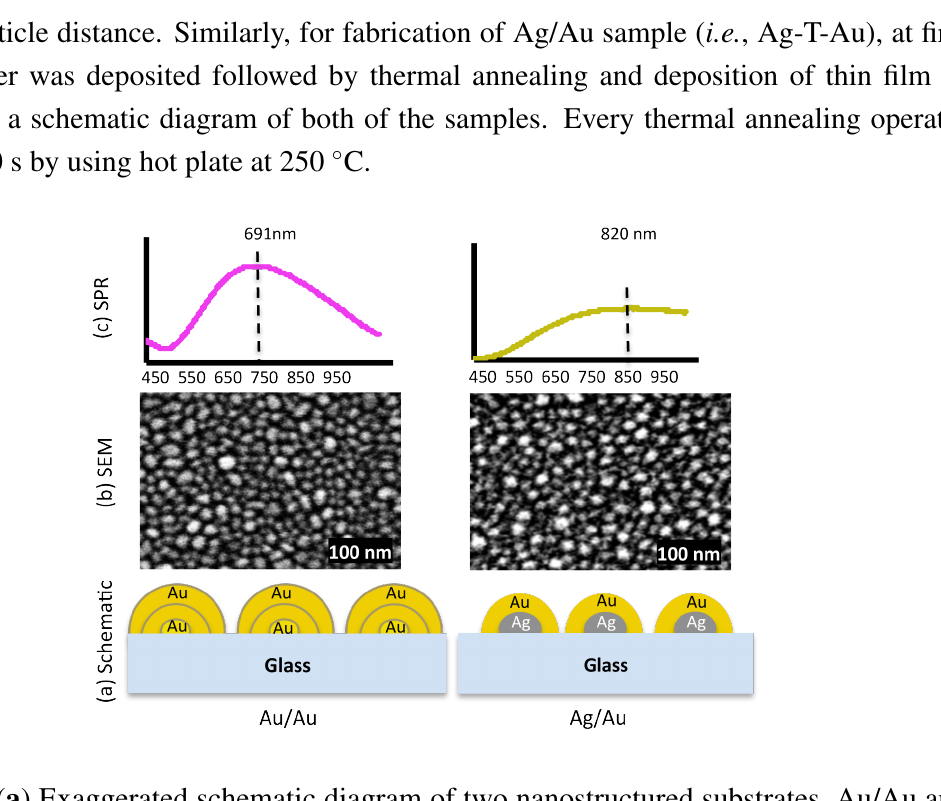
Figure 1. ( a ) Exaggerated schematic diagram of two nanostructured substrates, Au/Au and Ag/Au. ( b ) The SEM images show that the nanostructures are different in shape, size and inter-structure spacing. In the Au/Au sample, the smallest size is ≈ 6 nm and the largest ≈ 47 nm, and for Ag/Au sample, the smallest size is ≈ 6 nm and the largest ≈ 36 nm. ( c ) SPR spectra of the respective samples. The extinction peaks for samples Au/Au and Ag/Au are at 691 nm and 820 nm,